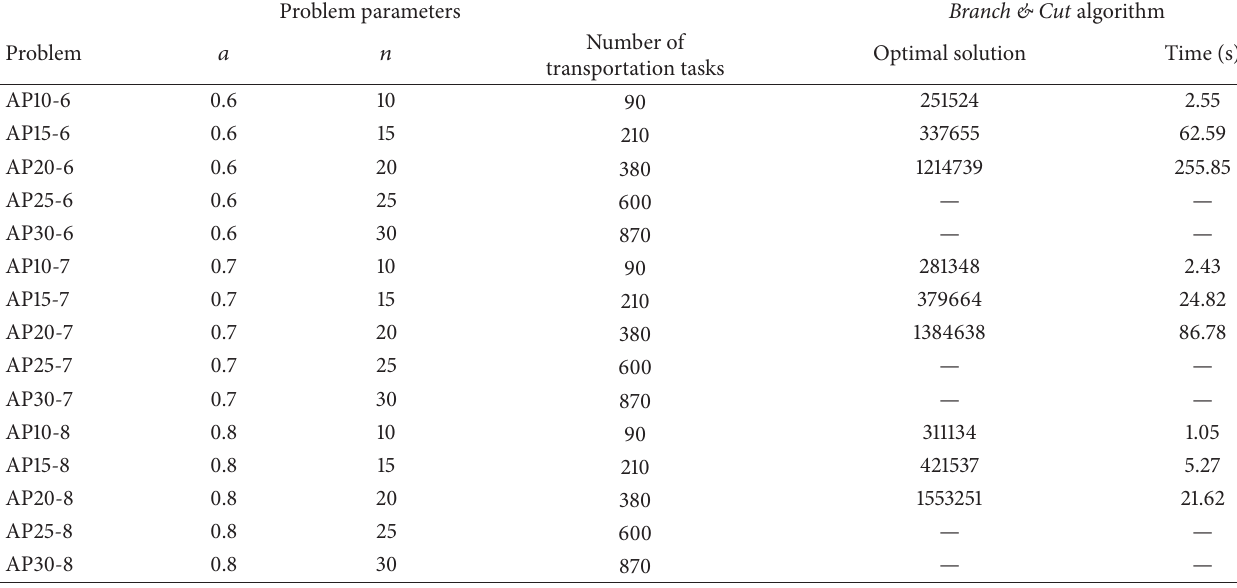
Table 1: Problem parameters of AP data package and computational result of Branch & Cut algorithm.